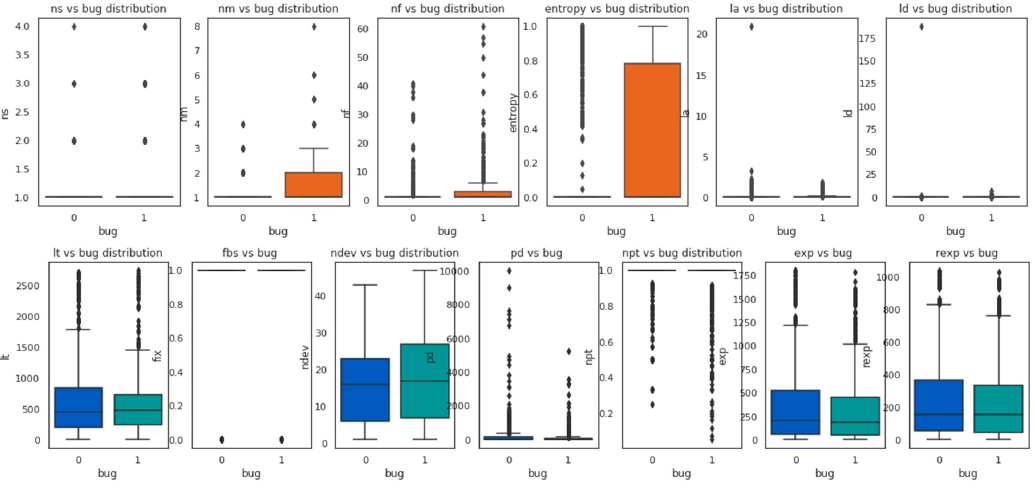
Figure 5. Distribution of dataset.